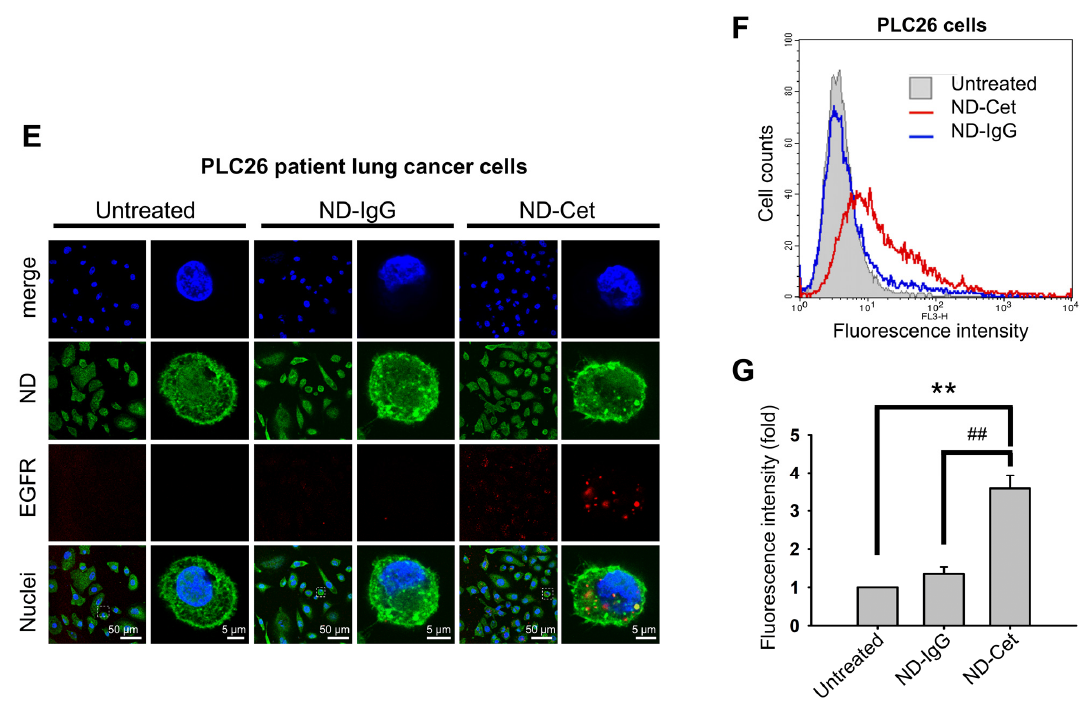
Figure 8. ND-Cet enhances the uptake ability through the selective binding of EGFR. ( A ) The proteins levels of EGFR, Oct4, and Nanog in the A549 and A549-ON cells were analyzed by western blot analysis using specific anti-EGFR, anit-Oct4, anti-Nanog, and anti-Actin (loading control) antibodies, respectively. Representative western blot data were shown from one of three separate experiments with similar findings. ( B ) Representative confocal microscopy images of A549 and A549-ON show the location of EGFR, Oct4, and Nanog proteins. The cells were incubated with rabbit anti-EGFR, anit-Oct4, and anti-Nanog, followed by goat anti-rabbit Dylight 488 antibody. The β -tubulin was stained with Cy3-labeled mouse anti- β -tubulin (red). The nuclei were stained with the Hoechst 33258 (blue). ( C ) A549 or A549-ON cells were treated with or without ND-Cet (10 µ g/mL:2.5 µ g/mL) for 24 h. At the end of treatment, the cells were subjected to flow cytometry. The fluorescence intensity of NDs was excited with wavelength 488 nm, and the emission was collected with >650 nm signal range (FL3 − H). The data of fluorescence intensity were quantified from a minimum of 10,000 cells using CellQuest software. Results were obtained from three separate experiments and the bar represented the mean ± S.E. * p < 0.05 indicates significant different between ND-Cet treated A549 and A549-ON cells. ( D ) Intracellular localization of ND-Cet in A549 and A549-ON cells. The cells were treated with or without ND-Cet (10 µ g/mL: 2.5 µ g/mL) for 24 h. At the end of treatment, the cells were incubated with rabbit anti-EGFR, then stained with goat anti-rabbit Dylight 488 antibody and observed by confocal microscopy analysis. Green color indicates the location of EGFR. Red color indicates the location of ND particles which excited with wavelength 580 nm, and the emission was collected in range from 600 to 700 nm. The nuclei were stained with Hoechst 33258. ( E ) The PLC26 cells were treated with ND-Cet (10 µ g/mL) or ND-IgG (10 µ g/mL) for 4 h and analyzed by confocal microscope. The green fluorescence from ND particles was excited by a wavelength of 580 nm and the emission was collected in the range 600–700 nm. EGFR and nuclei exhibited green and blue color, respectively. ( F ) The PLC26 cells were plated in 35 − mm Petri dish. Then, the cells were treated with ND-Cet (10 µ g/mL) or ND-IgG (10 µ g/mL) for 4 h. At the end of treatment, the cells were trypsinized and then subjected to flow cytometry. The data of fluorescence intensity was quantified from a minimum of 10,000 cells using CellQuest software. ( G ) The bar represented the mean ± S.E. ** p < 0.01 indicates significant difference between untreated and ND-Cet treated PLC26 cells. ## p < 0.01 indicates significant difference between ND-IgG and ND-Cet treated PLC26